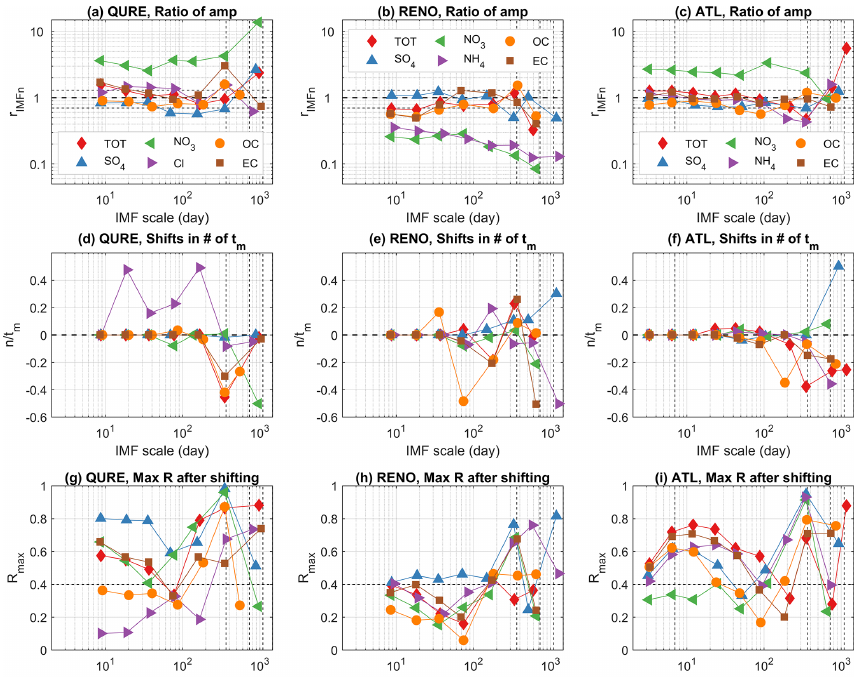
Figure 11. Model performance at all temporal scales for sites QURE, RENO, and ATL. (a–c) Ratio of mean amplitude of corresponding IMFs with similar characteristic mean periods (ideal ratio = 1.0); (d–f) the phase shift n in the number of mean periods (average mean period of corresponding IMFs decomposed from observations and model simulation). (g–i) The maximum correlation R max can be achieved by shifting the modeled time series. The average mean period of corresponding IMFs decomposed from observations and CMAQ of total and speciated PM 2 . 5 are represented on the x axis; all metrics on the y axis are unitless. Horizontal reference lines are drawn at 0.7 and 1.3 in (a–c) . Weekly, annual, and interannual (2- to 3-year) scales are marked with dashed vertical